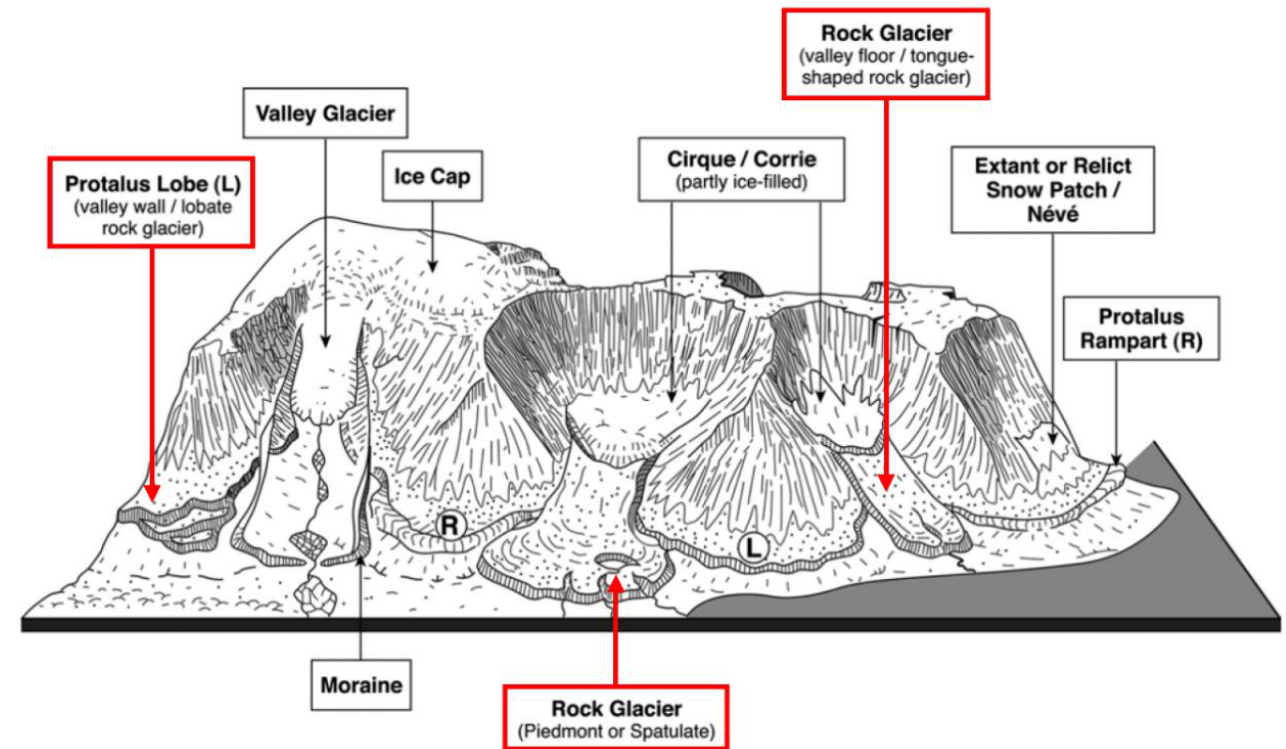
Figure 5. Three classifications of rock glaciers geometry; lobate rock glacier, piedmont/spatulate rock glacier and tongue-shaped rock glacier (indicated in red). After Humlum et al. [81], Martin and Whalley [74], and Hamilton and Whalley [84].